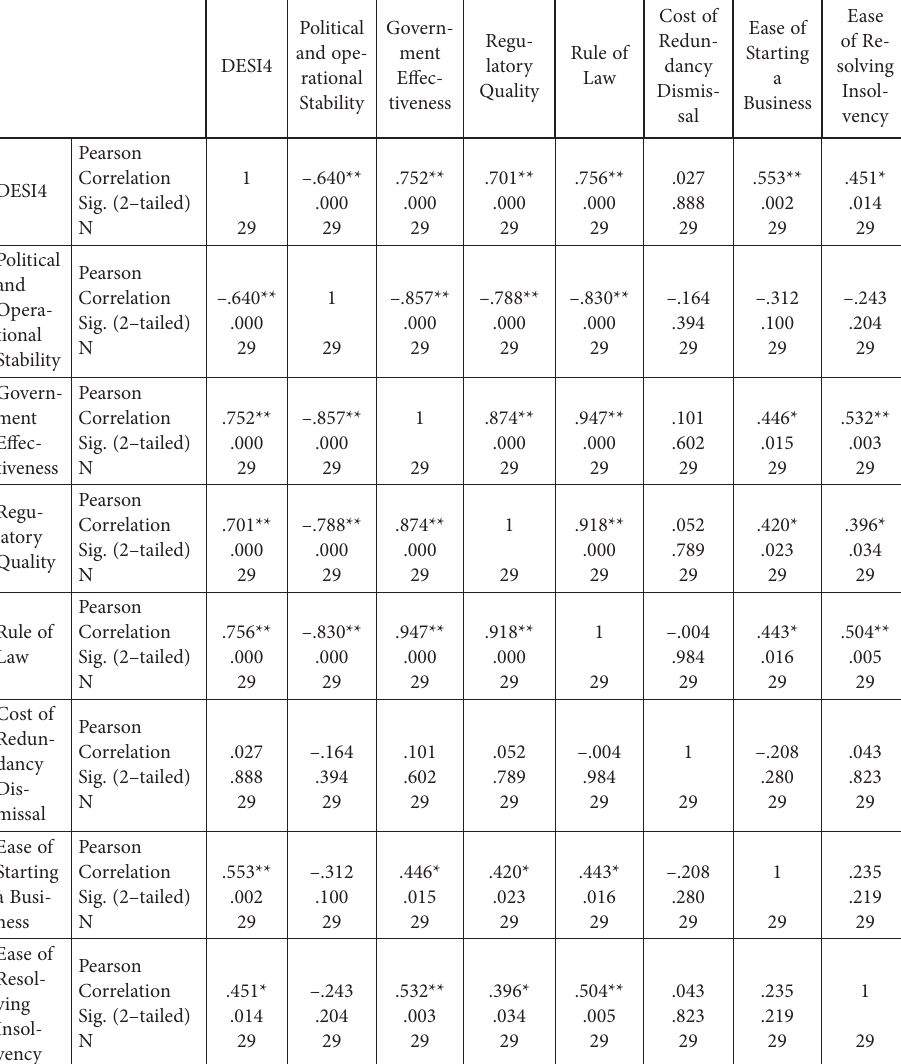
Table A2. Correlations between DESI4 and Institutions sub-pillars and between Institutions sub-pillars